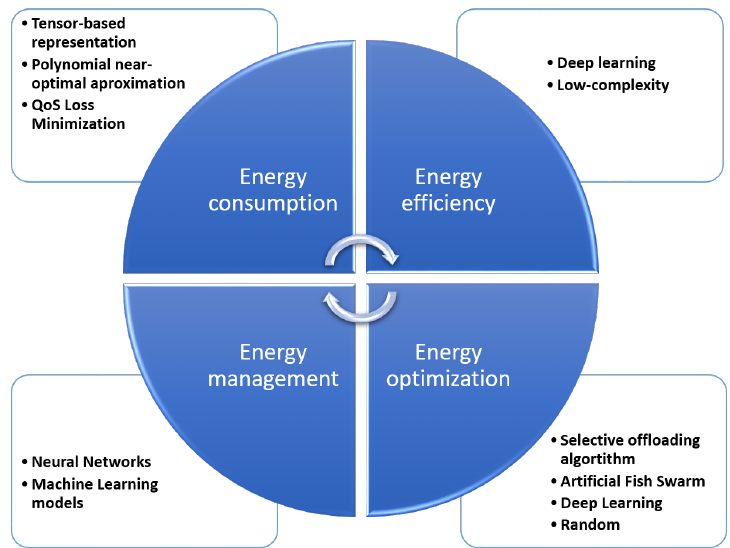
Figure 7. Main algorithms used in the analyzed papers.